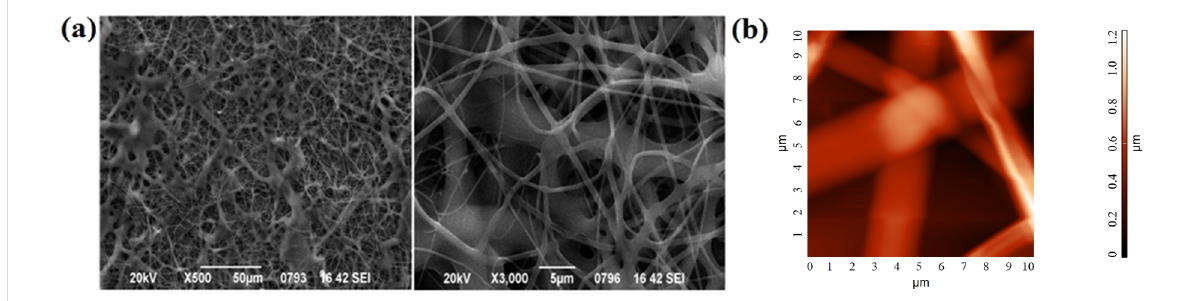
Figure 4: (a) Representative SEM micrograph of electrospun CA:dexam fibers, (b) AFM topography image of CA:dexam scaffolds with root mean square S q = 206 nm and peak-to-peak S y = 1203 nm.